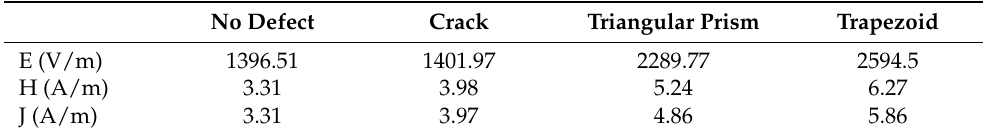
Table 1. Peak value of field distribution at rectangular defects.